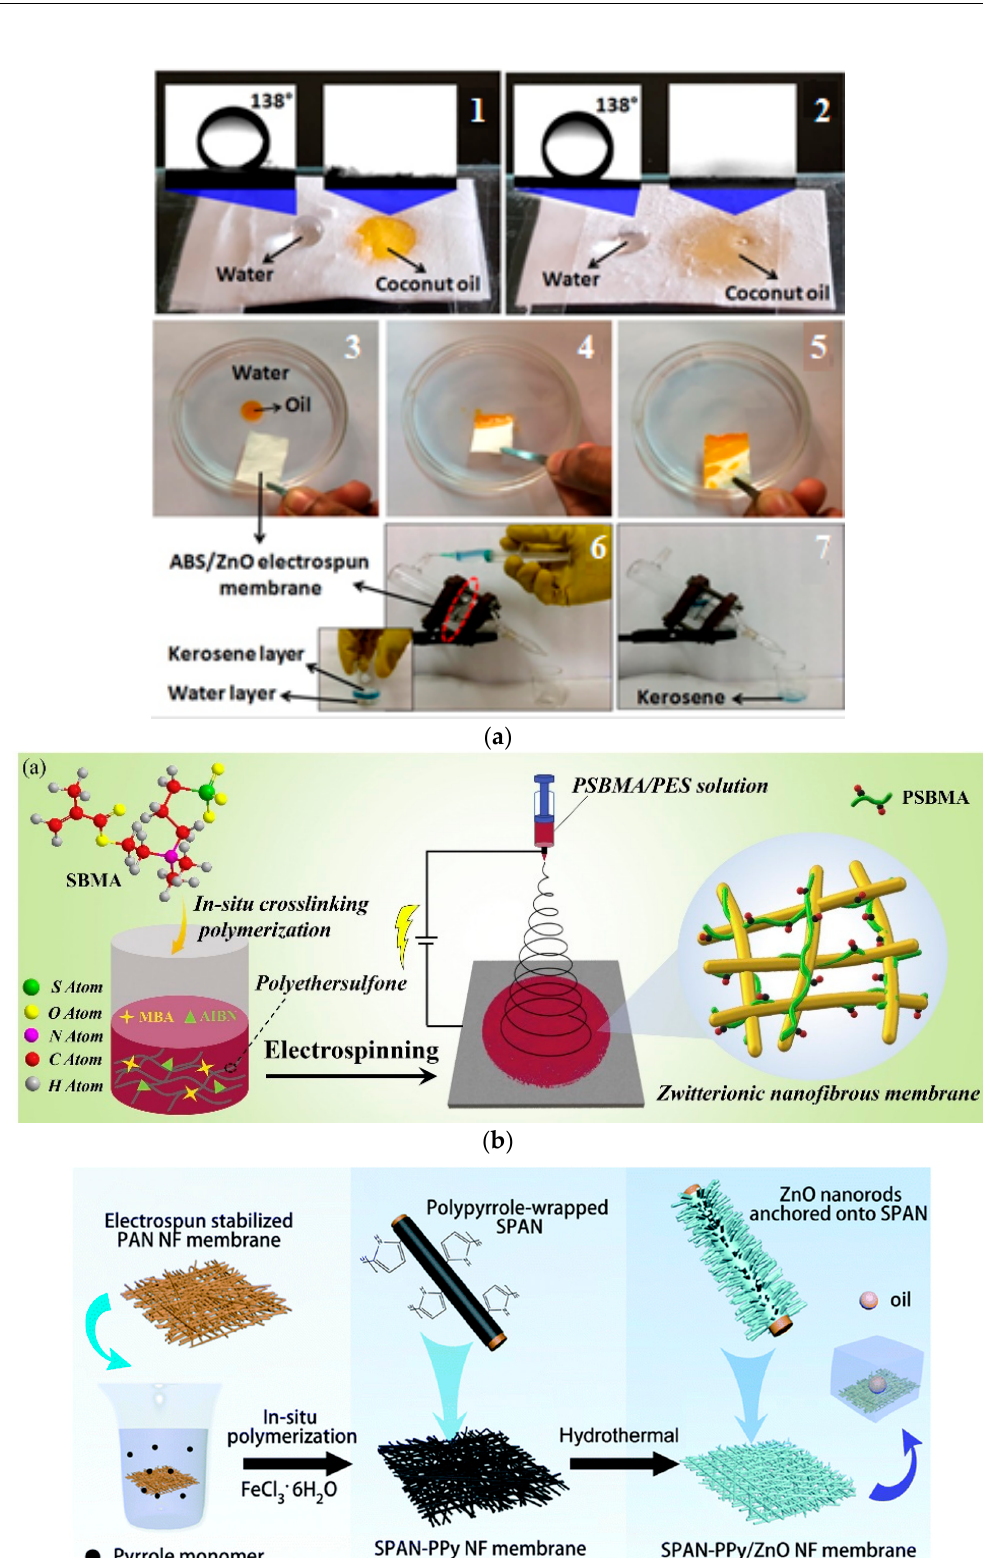
Figure 6. ( a ) Photographs of water and oil absorption characteristics of an electrospun membrane ( 1 ) ABS, ( 2 ) ABS/ZnO; ( 3 – 5 ) selective absorption process of ABS/ZnO samples from the oil–water mixture; and ( 6 – 7 ) gravity-driven oil–water separation (reproduced from [146] with permission of Elsevier, 2019). ( b ) Schematic illustration of the fabrication of PSBMA/PES NFMs (reproduced from [148] with permission of Elsevier, 2020). ( c ) Schematic illustration of the fabrication of a SPAN-PPy/ZnO nanofibrous membrane (reproduced from [151] with the permission of the Royal Society of Chemistry, 2020).